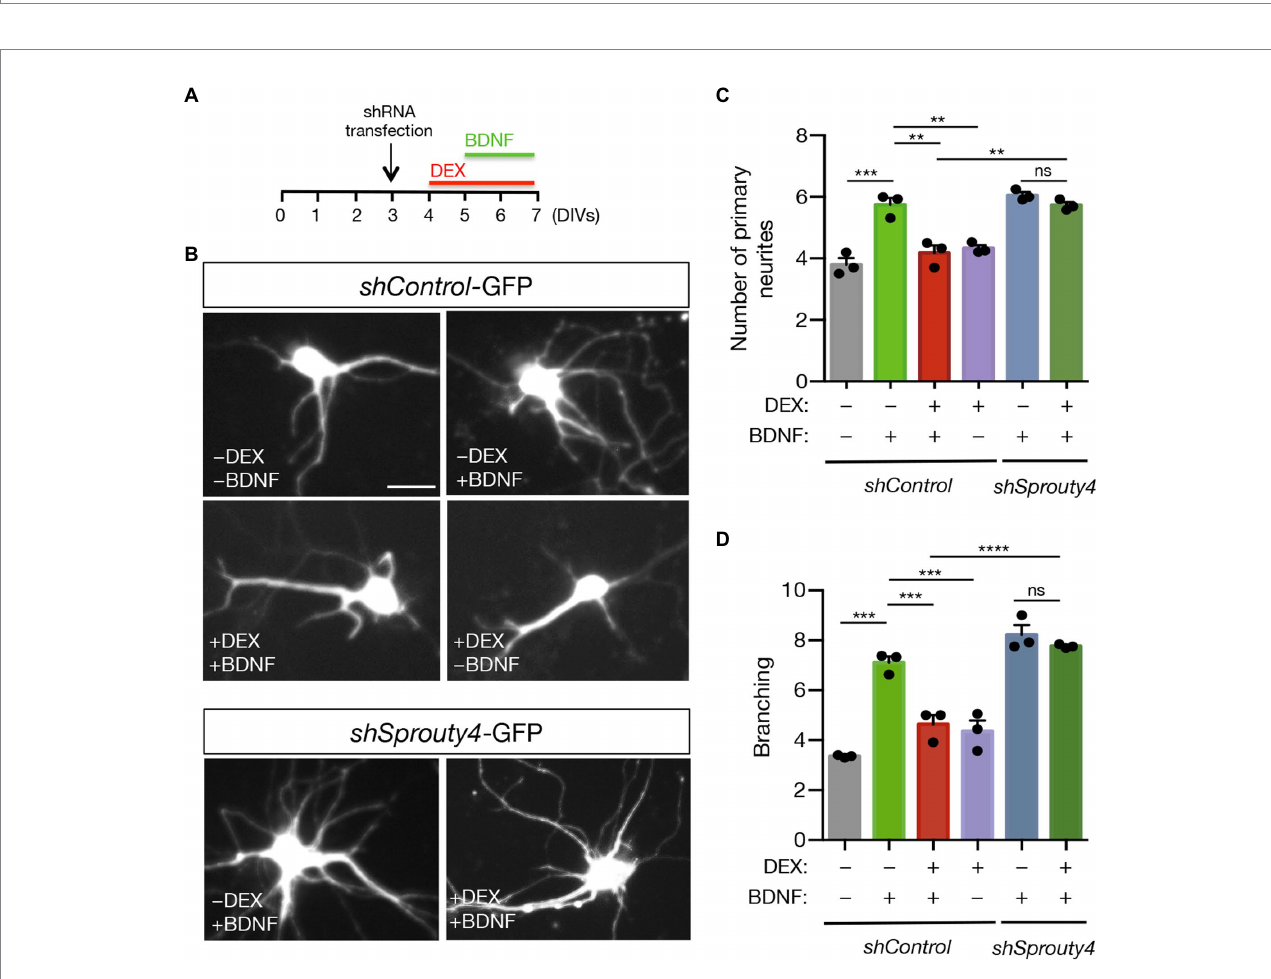
FIGURE 5 Knockdown of Sprouty4 abrogates the inhibitory effect of DEX on the morphological differentiation induced by BDNF in hippocampal neurons. (A) Experimental scheme of control and Sprouty4 shRNA transfected neurons treated with DEX and/or BDNF for the indicated days in vitro (DIV). (B) Representative images of rat hippocampal neurons transfected with control or Sprouty4 shRNA vectors and treated or not with DEX and/or BDNF as indicated in (A) . Scale bar, 20 μ m. (C,D) Quantification of primary dendrites (C) and total dendritic branching (D) of hippocampal neurons transfected with either control or Sprouty4 -shRNA-GFP vector and then treated with DEX and/or BDNF as indicated in (A) . A total of 36–45 neurons per experimental condition were analyzed. The results are shown as mean ± s.e.m. of n = 3 independent assays. ** p < 0.01, *** p < 0.001, **** p < 0.0001 by one-way ANOVA followed by Tukey’s multiple comparisons test. ns, not significant.